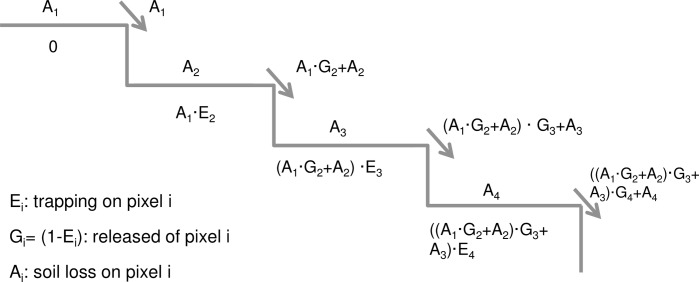
Simplified illustration of sediment route in InVEST model.